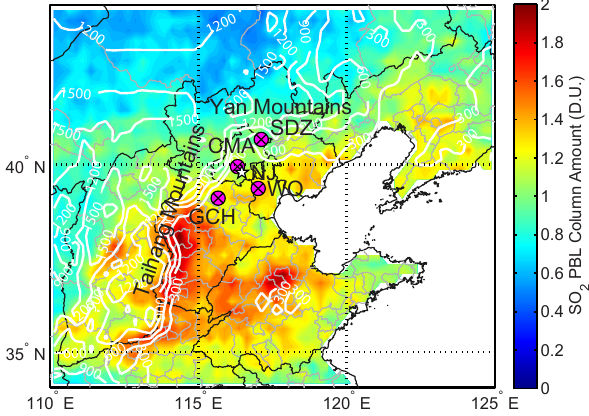
Figure 1. Location of the Shangdianzi (SDZ), China Meteorolog- ical Administration (CMA), Gucheng (GCH), Wuqing (WQ) site, the Nanjiao meteorological station (NJ) and the Yan and Taihang Mountains. The average distribution of OMI SO 2 column concen- tration in 2009 is displayed as the shaded contour, while the white contour lines show the terrain height